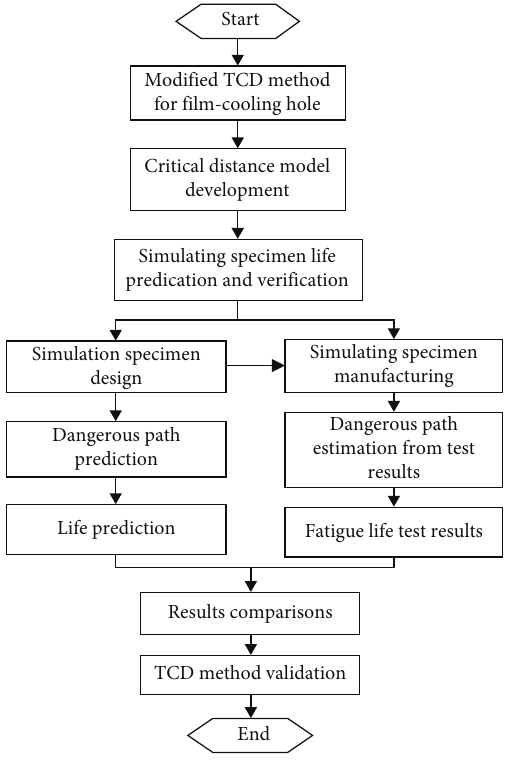
Figure 1: Design